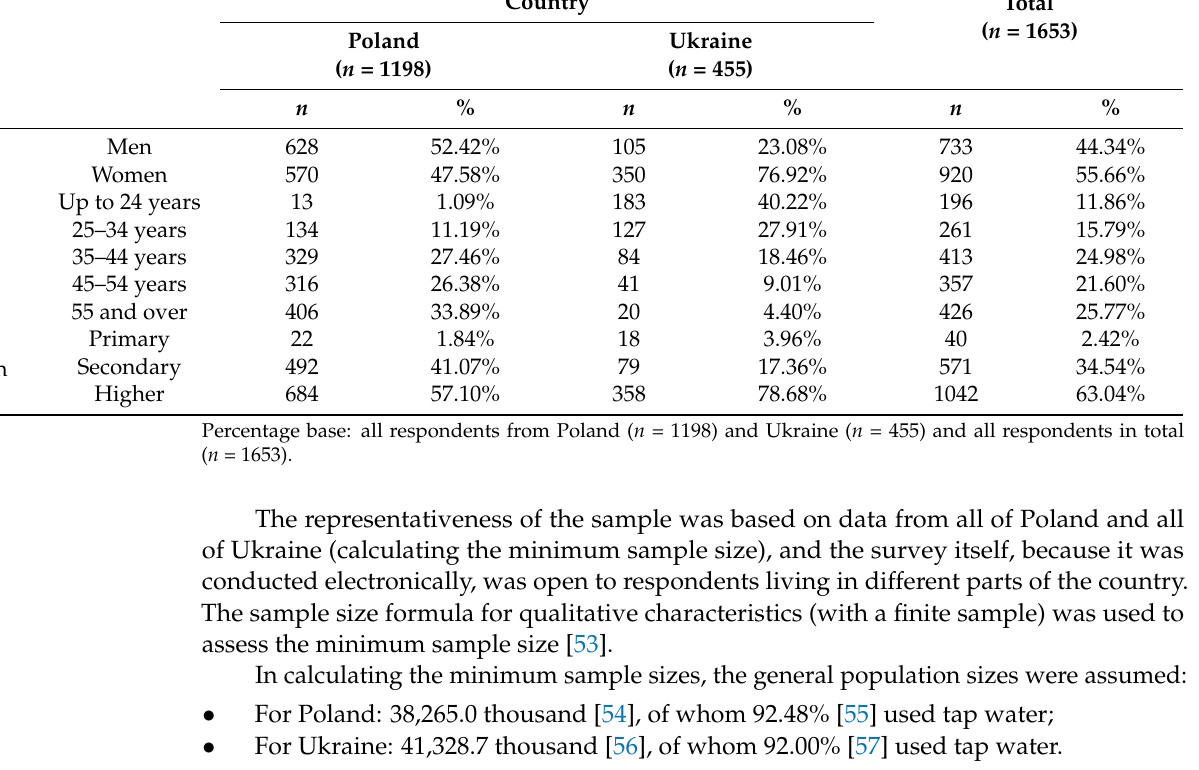
Table 3. Assessment of surface water quality in Ukraine.